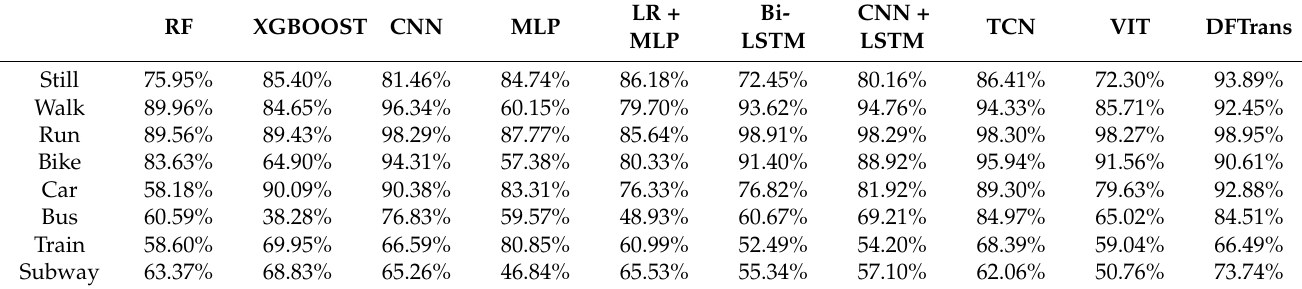
Table 6. Accuracy of different algorithms on the SHL dataset.